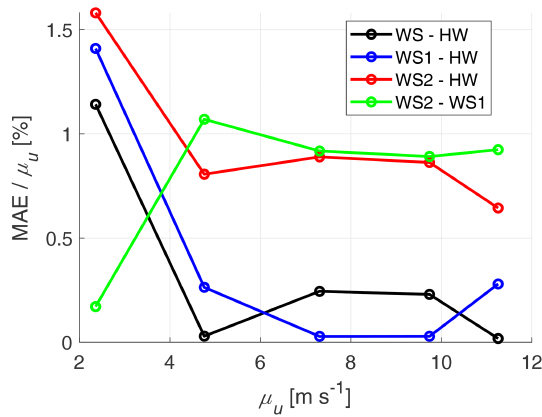
Figure 18. Normalised mean averaged error of the measured wind speed with respect to the hot-wire anemometer for each of the five cases at 451.7Hz.